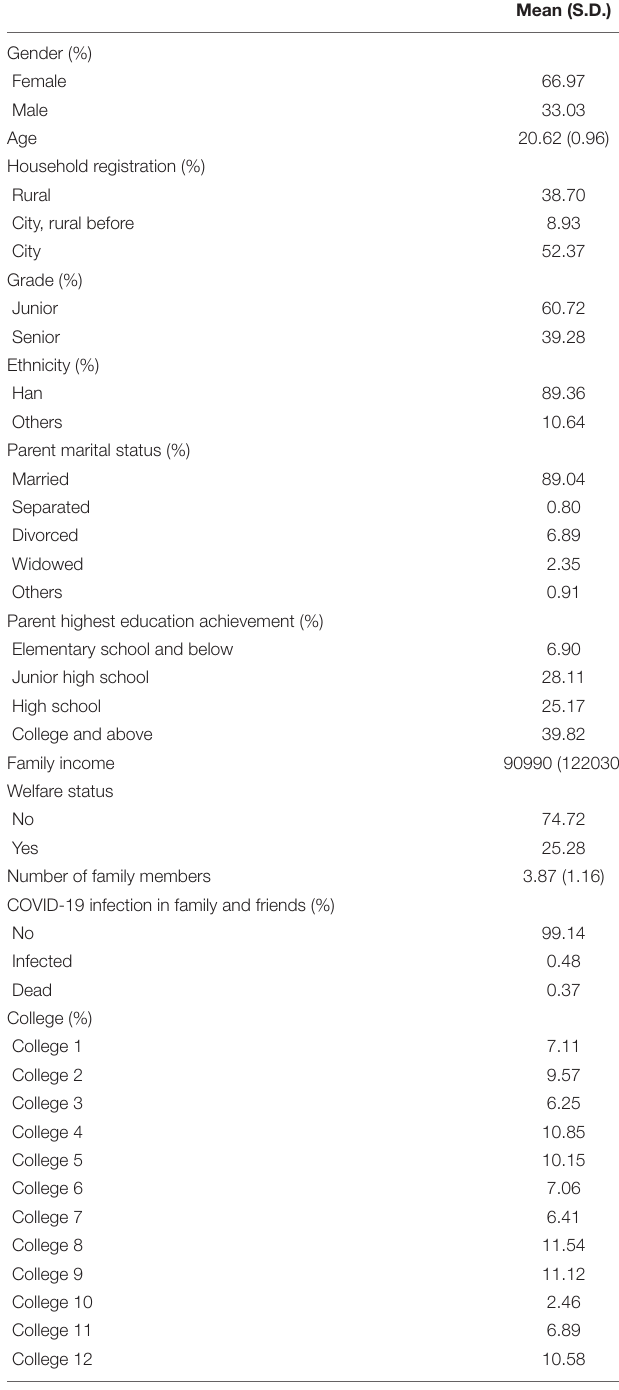
TABLE 1 | Level of grit, mindfulness, adverse childhood experience, and COVID-19 infection.